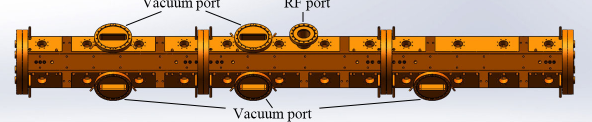
FIG. 3. Structure drawing of the XiPAF RFQ.